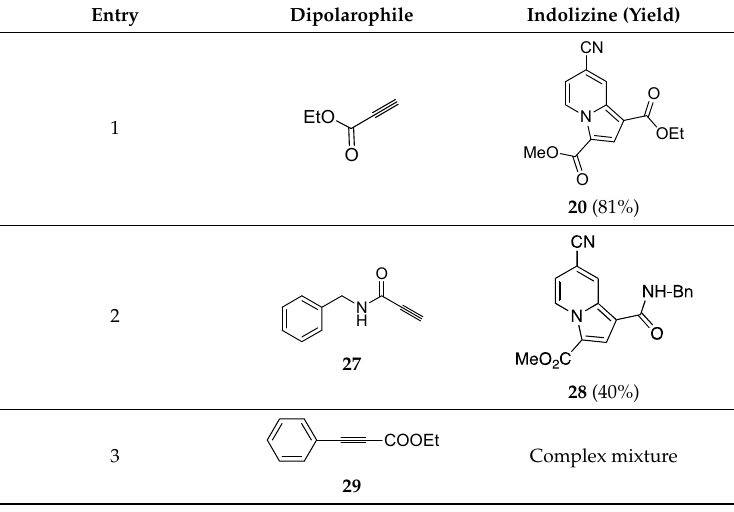
Table 6. Reaction of 4-cyanopyridinium salt 7 with various dipolarophiles.